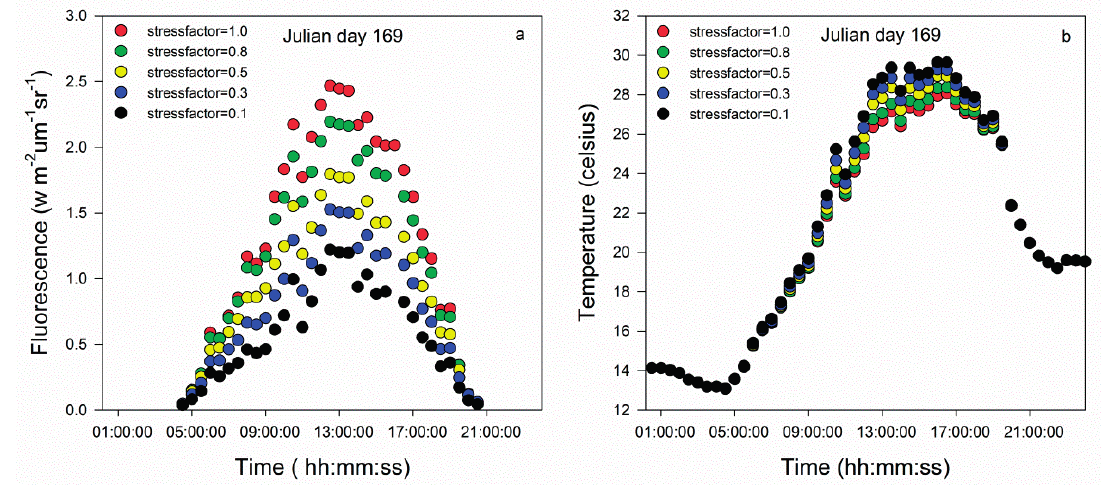
Figure 1. ( a ) Time series of the fluorescence. ( b ) Time series of the canopy